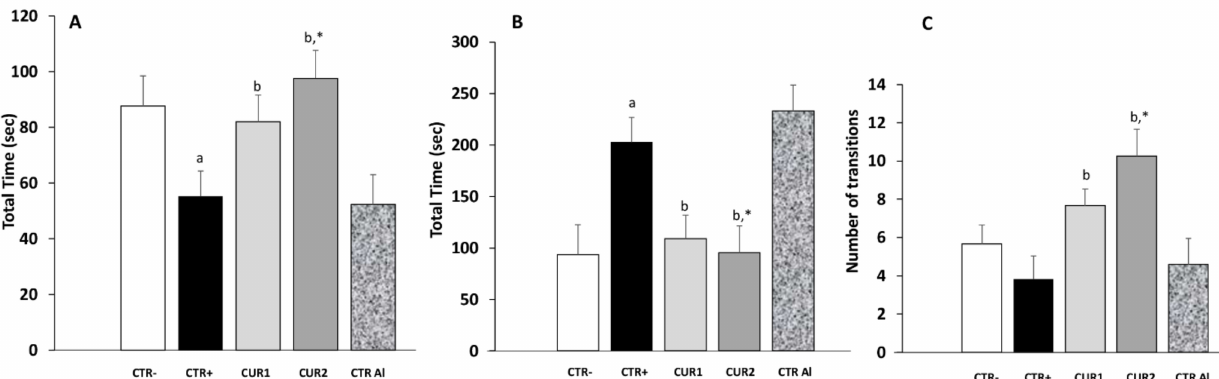
Figure 2. Effect of co and post-treatment of curcumin on the anxiety in the rat model of AD induced by chronic administration of AlCl 3 . ( A ) time spent in the white area; ( B ) Time spent in the black area; ( C ) number of transitions between white and black areas. Values are mean ± SEM. Note: CTR − : negative control group; CTR+: positive control group (treated by aluminum chloride (AlCl 3 )); CUR1: co-treatment with curcumin; CUR2: post-treatment with curcumin; CTRAl: exposed to AlCl 3 for 90 days and survive 60 days without any treatment; a: p < 0.05 as compared to CTR − group; b: p < 0.05 as compared to CTR+ group; *: p < 0.05 as compared to CTRAl group, repeated measures two-way ANOVA followed by Tukey’s test for multiple